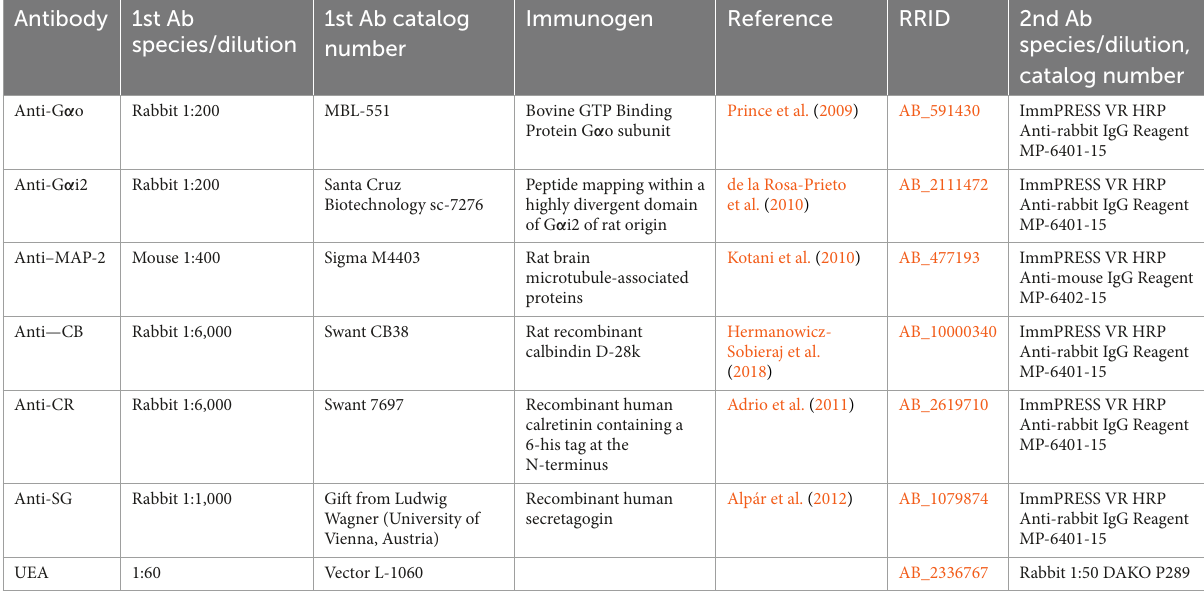
TABLE 1 Detailed information on the antibodies and lectins used in this study. Antibody 1st